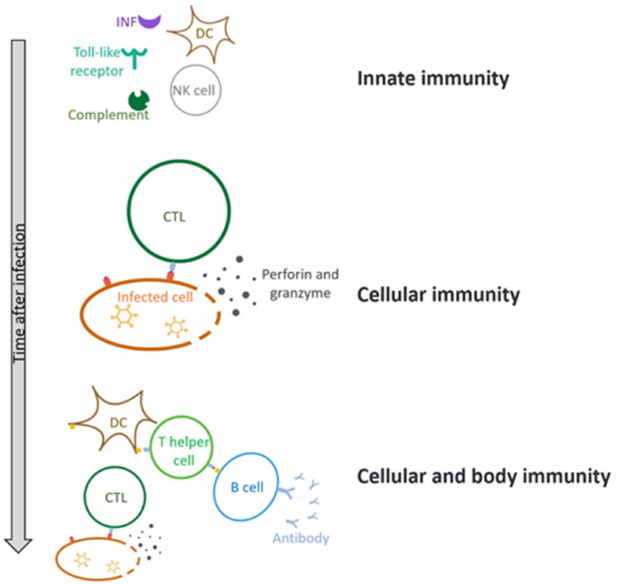
Figure 4. The immune response of HAdV after it enters the body. The body first produces an innate immune response, involving dendritic cells (DC cells), natural killer cells (NK cells), interferon (INF), and so on. Over time, cellular and humoral immunity comes into play. CTL—Cytotoxic T